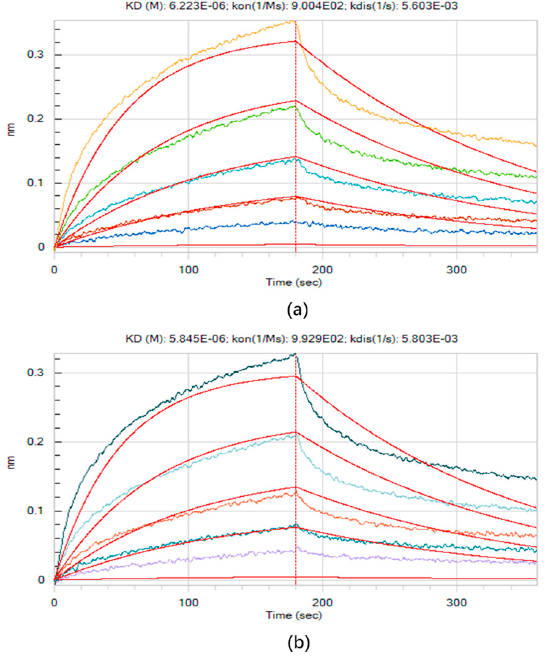
Figure 2. ( a ) K D determination results of abrin-2 with abrin; ( b ) K D determination results of abrin- M1 with